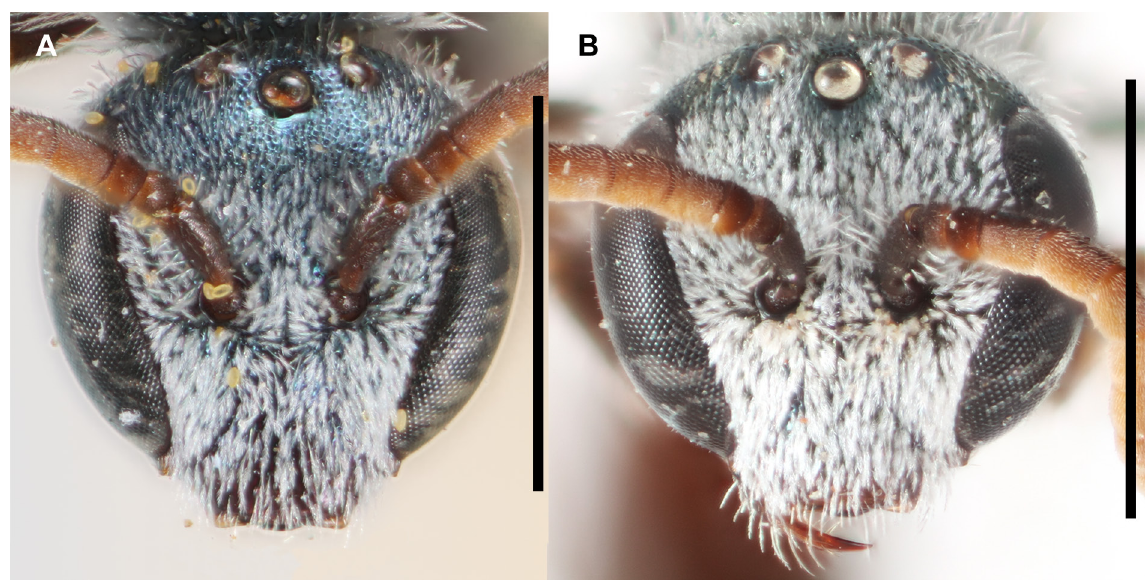
Fig. 104. Face. A . Lasioglossum gaudiale (Sandhouse, 1924), ♂, slightly narrower. B . L. gloriosum sp. nov., ♂, broad. Scale bars = 1 mm.